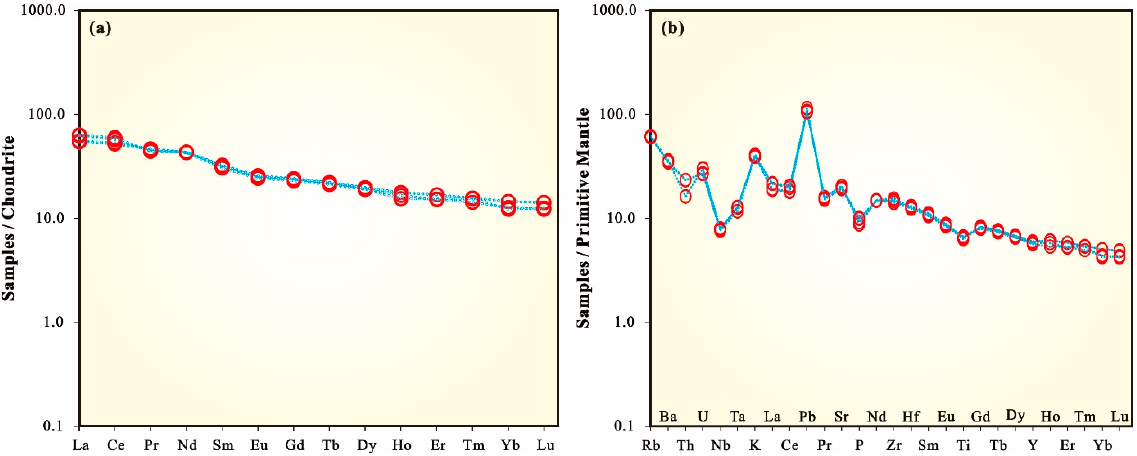
Figure 7. ( a ) Chondrite-normalized REE patterns and ( b ) primitive mantle-normalized trace element patterns for the hornblende gabbro samples from the Baogeqi gabbro pluton. The normalization values of chondrite are from [48] and data for primitive mantle are from [49].